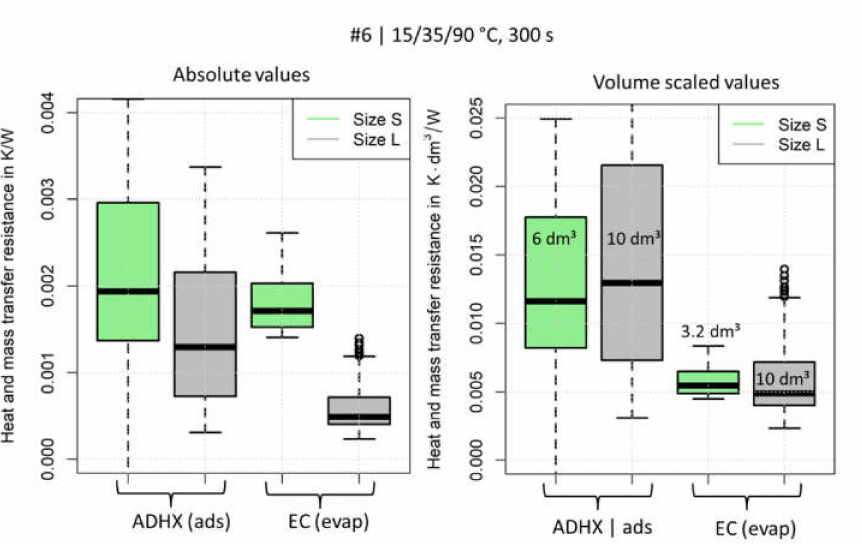
Figure 18. Boxplot of heat and mass transfer resistances for measurements under 15/35/90 ◦ C temperature conditions and 300 s half cycle time in absolute numbers ( left ) and volume scaled values ( right ). The component volume is plotted for convenience. The volume scaled overall heat and mass transfer resistance are nearly the same for ‘Size S’ and ‘Size L’